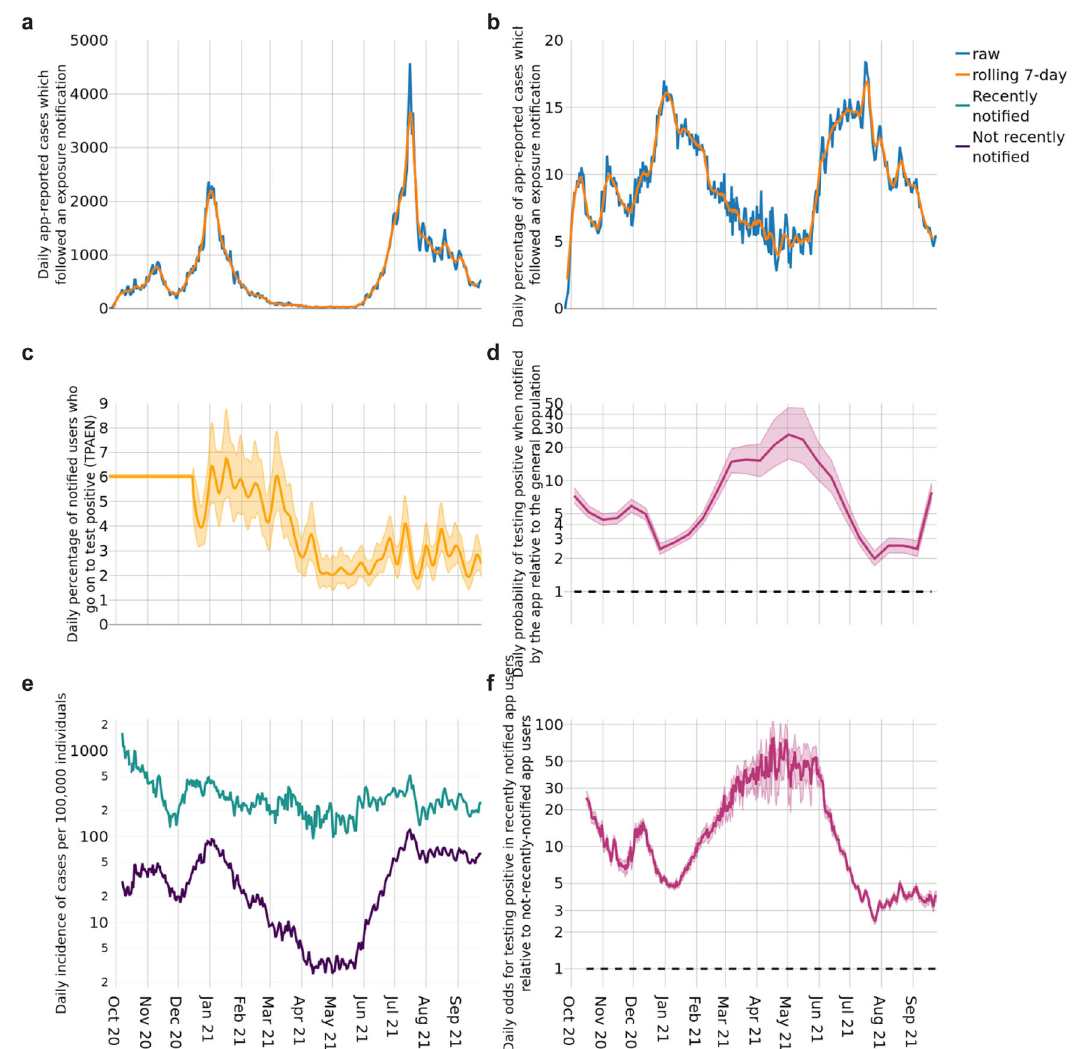
Fig. 5 | Testing positive after exposure noti fi cation. a The daily number of app- reportedcases which followed an exposurenoti fi cation, and rolling 7-dayaverage. b The daily and rolling 7-day average percentage of app-reported cases which followed an exposure noti fi cation. c The mean estimated proportion of noti fi ed individuals who enter a positive test result into the app shortly after exposure noti fi cation (TPAEN). Shading around the line indicates the 95% credible interval. d Theprobabilityoftestingpositiveafternoti fi cationrelativetoarandommember of the 16+ population, shown on a logarithmic scale. The central estimate and